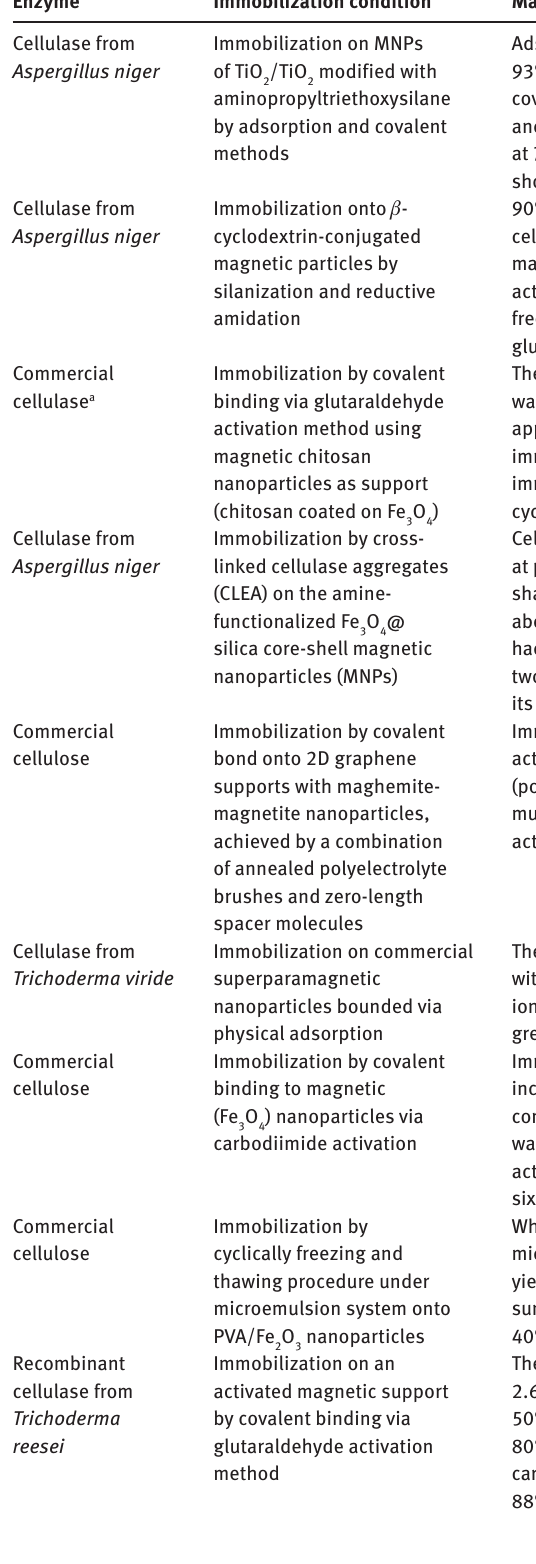
Table 2: Immobilization of cellulase on different magnetic nanoparticles, methodology, and main results. Enzyme Immobilization condition Main